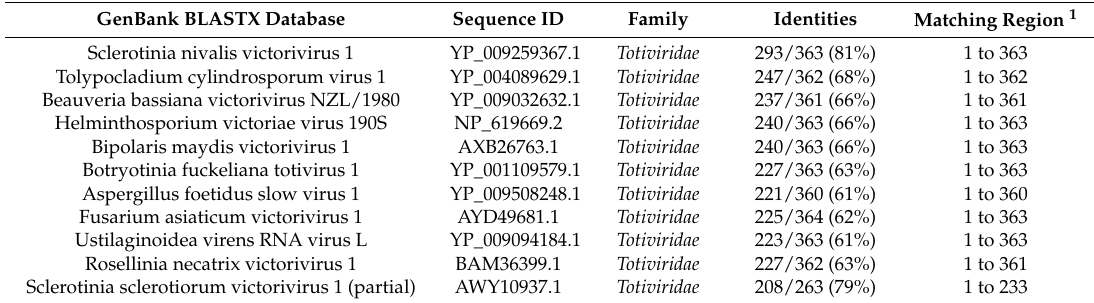
Table 4. BLASTX comparison of a 1261 nt capsid protein (CP) sequence obtained from cloning 5 kb dsRNA of 06P G. abietina